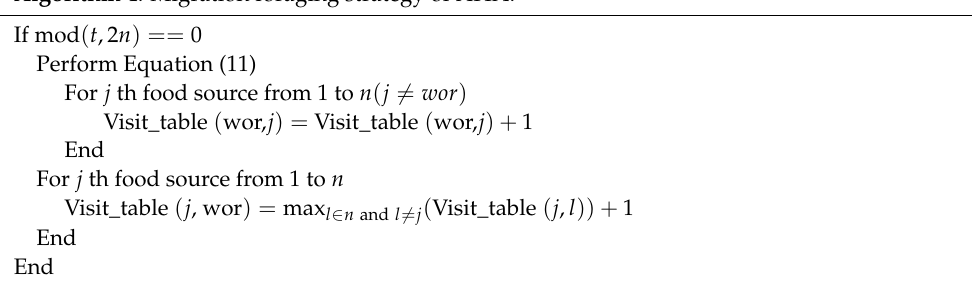
Algorithm 4 : Migration foraging strategy of